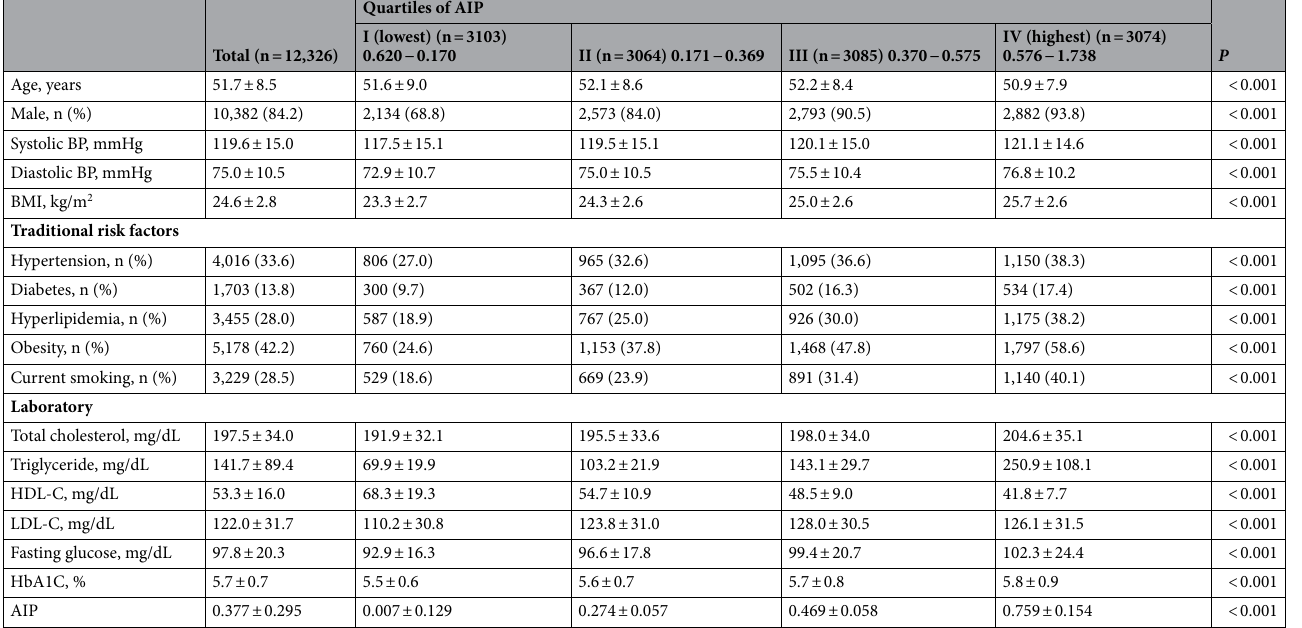
Table 1. Clinical characteristics of the study cohort. Values are presented as the mean ± standard deviation or number (%). AIP atherogenic index of plasma , BMI body mass index, BP blood pressure, HbA1C glycated